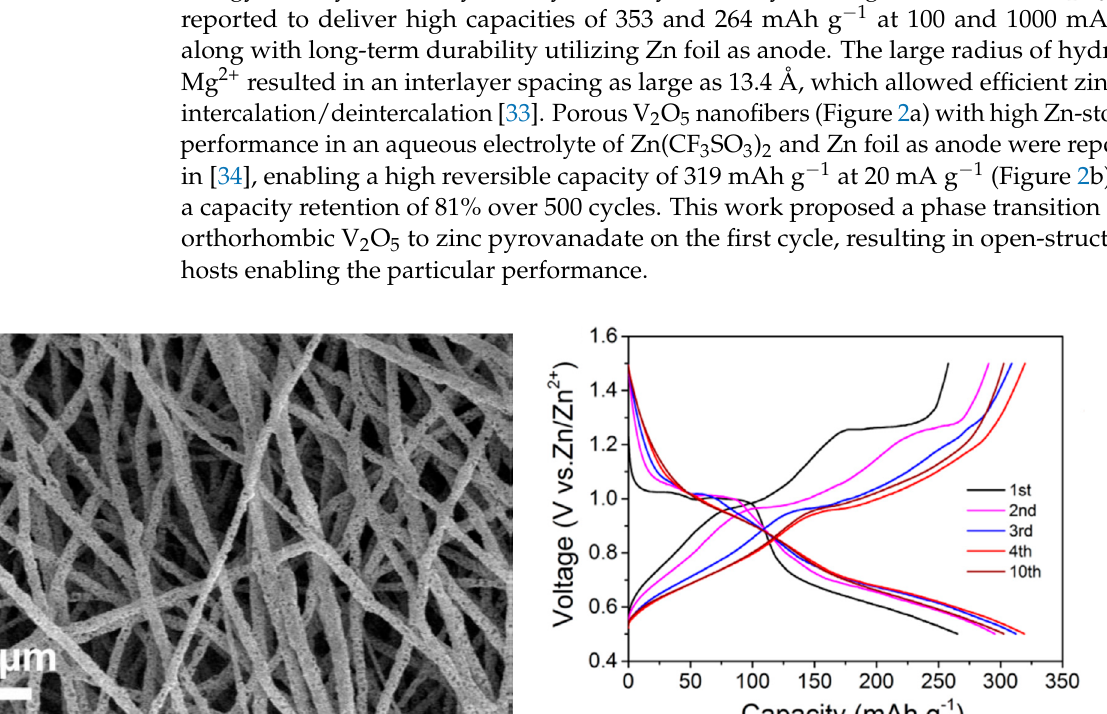
Figure 2. ( a ) SEM image of as-prepared V 2 O 5 nanofibers. ( b ) Galvanostatic discharge/charge profiles at 20 mA g − 1 [34].